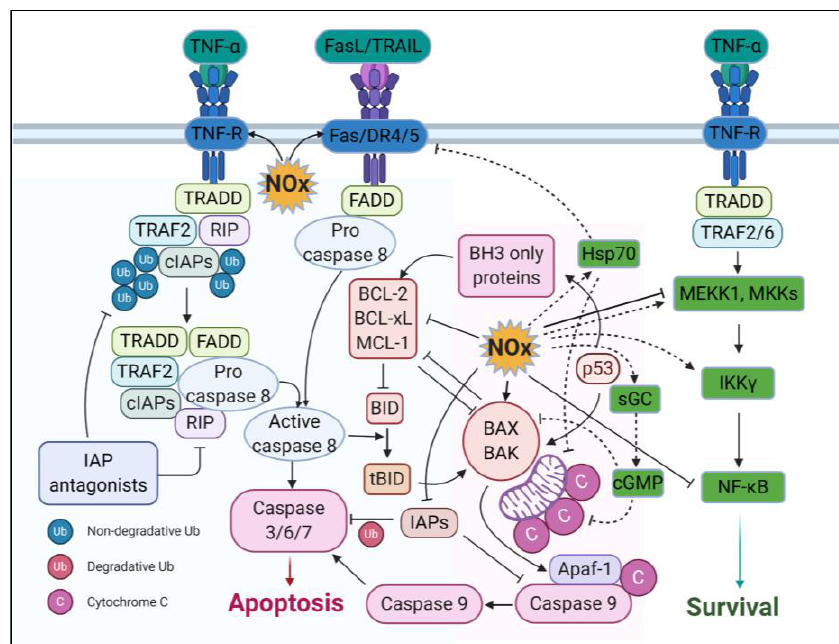
Figure 4. Apoptosis induced by high levels of NO is mediated via activation of the extrinsic apoptosis pathway which involves the TNFR and Fas/Death Receptors. In contrast, low levels of NO repress the intrinsic apoptosis pathway in a cGMP dependent manner (low NO, dashed line; high NO, solid line). Created with BioRender.com.